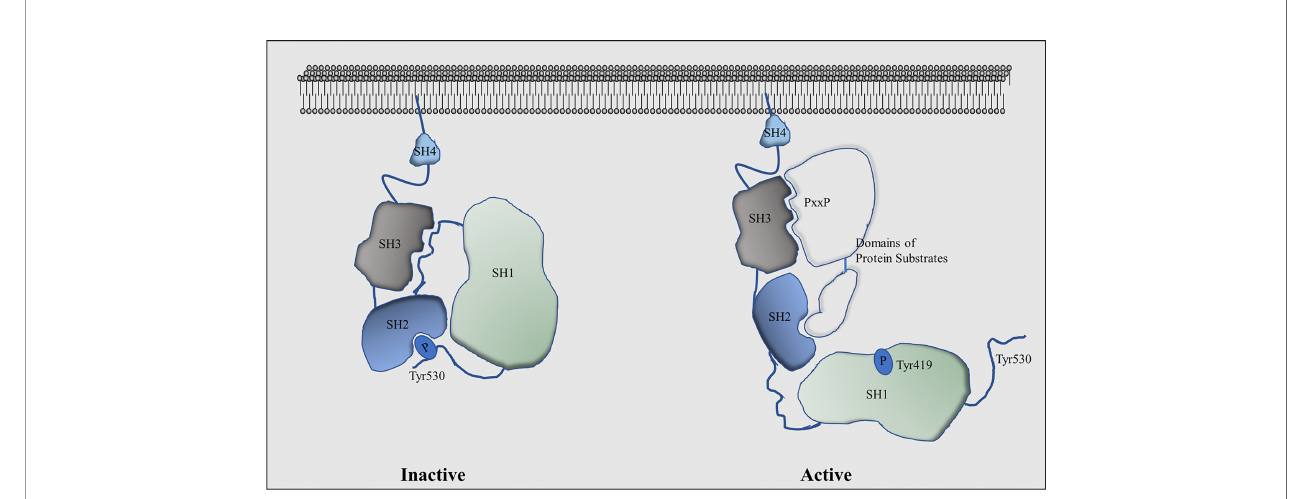
FIGURE 2 | Functional domains of the Src kinase and their conformational changes in active and inactive